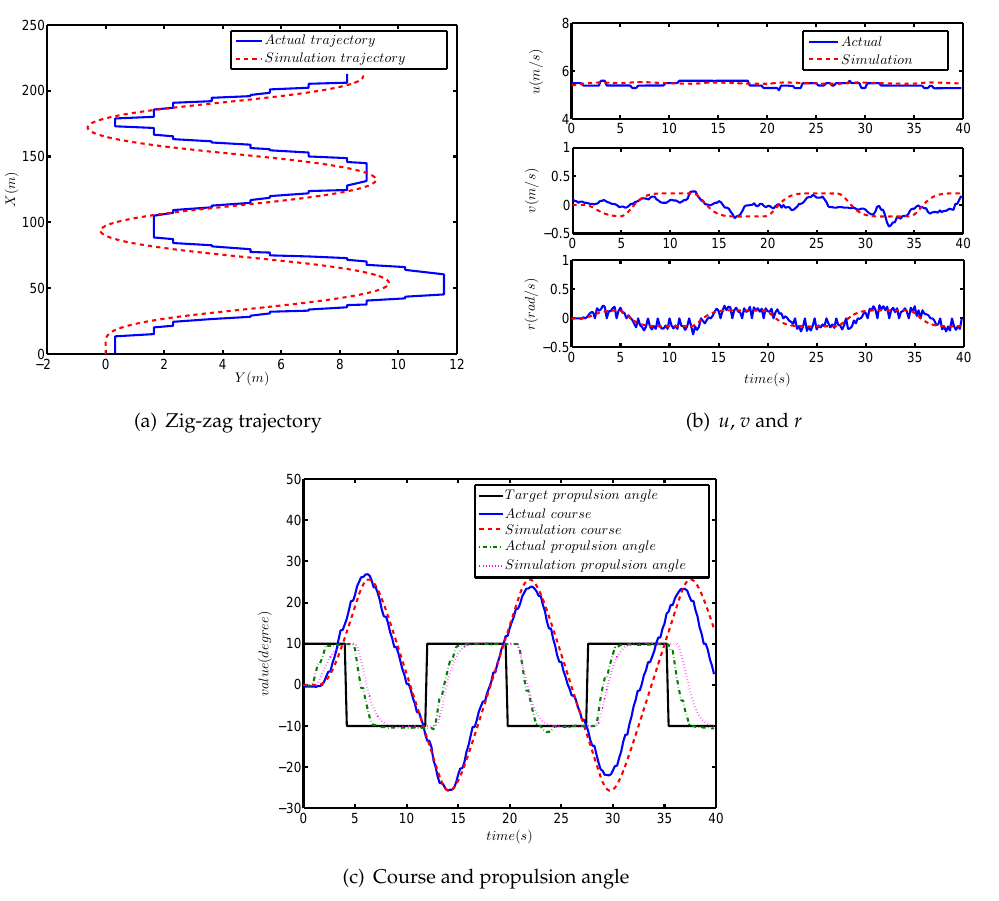
Figure 7. The comparison results of the zig-zag